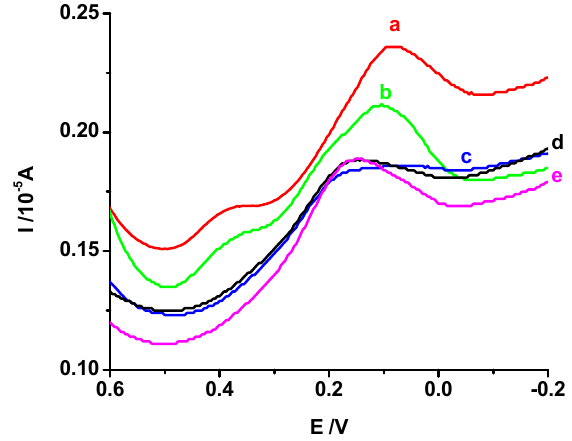
Figure 8. DPV of MIP/Au in different concentrations of TBP by drop-coating method (a) 1.0 × 10 − 3 ; (b) 1.0 × 10 − 4 ; (c) 1.0 × 10 − 5 ; (d) 1.0 × 10 − 6 ; (e) 1.0 × 10 − 7 mol · L − 1 .